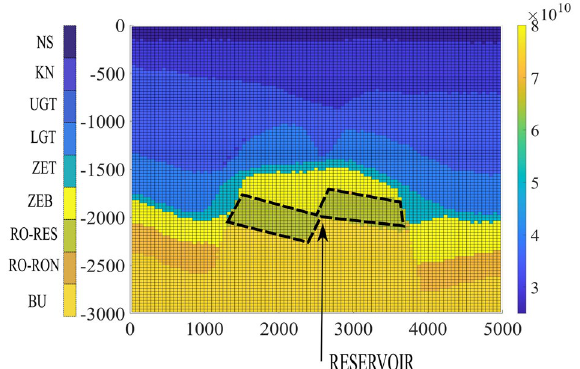
Figure 9. Field scale test case: the above shows the variation of the Youngs modulus inside the geological domain highlighting the reservoir boundary at a depth of around 2000 m. Roller boundary conditions are imposed in the left, bottom and right face and the top face has free stress boundary conditions.